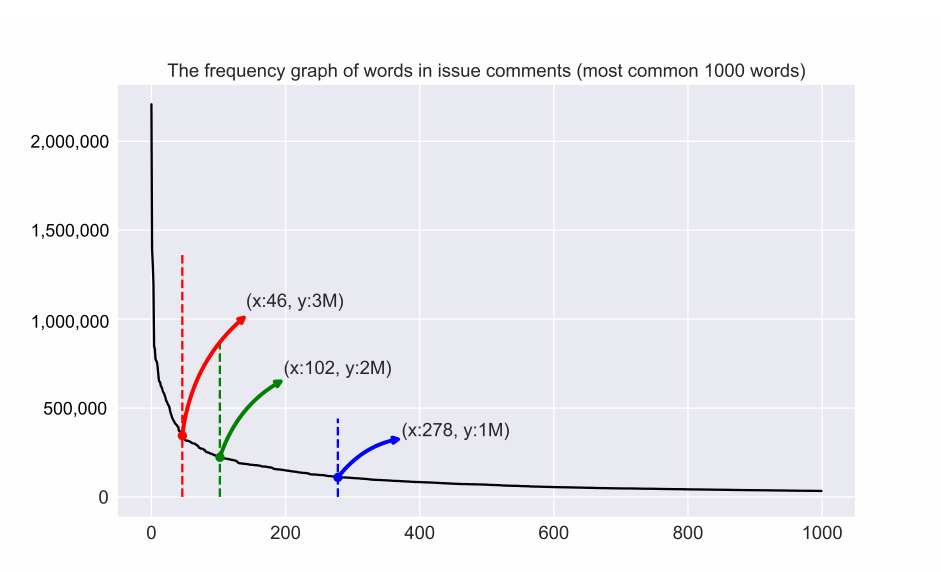
Figure 3. The zipf distributions of words in comments.